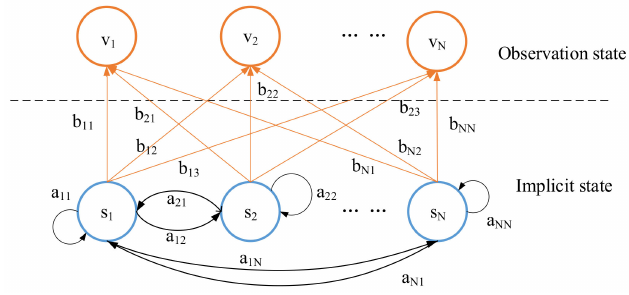
Figure 4. Hidden Markov State